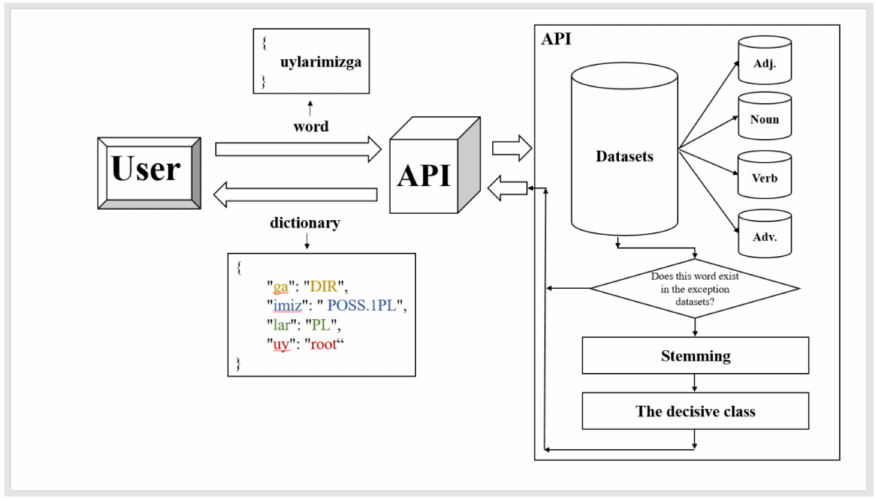
Figure 3. Detailed scheme of working